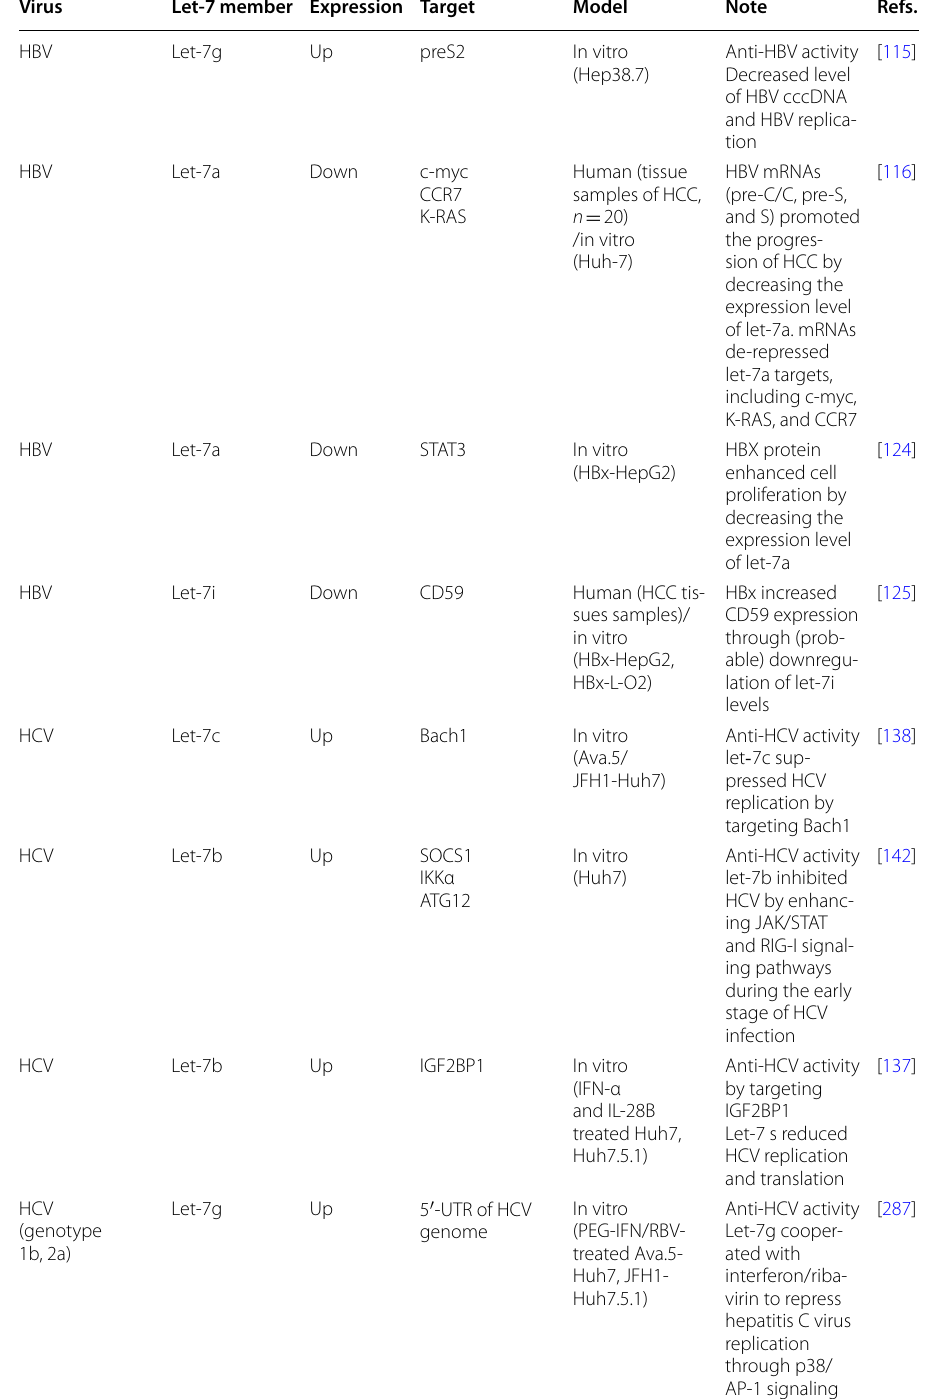
Table 2 The role of let‑7 family members in viral infections